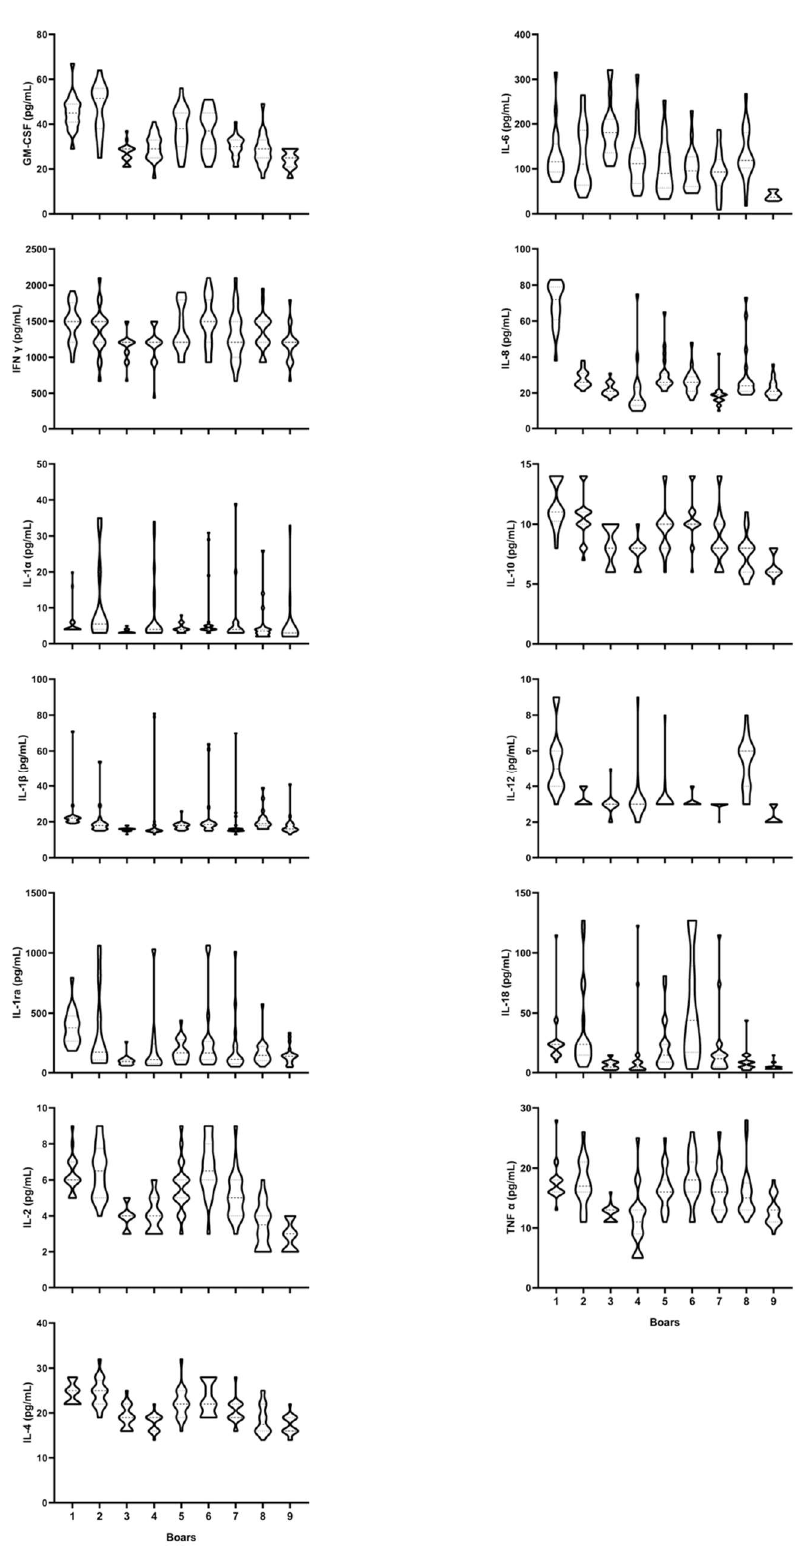
Figure 1. Violin plots representing the concentrations of granulocyte macrophage colony-stimulating factor (GM-CSF), interferon-gamma (IFN γ ), interleukin (IL)-1 α , IL-1 β , IL-1ra, IL-2, IL-4, IL-6, IL-8, IL-10, IL-12, IL-18, and tumor necrosis factor- α (TNF α ) in seminal plasma of nine boars (20 ejaculates per boar). The dashed line represents the median and the dotted lines the 25% and 75% quartiles. All cytokines showed di ff erences among boars ( p < 0.001).